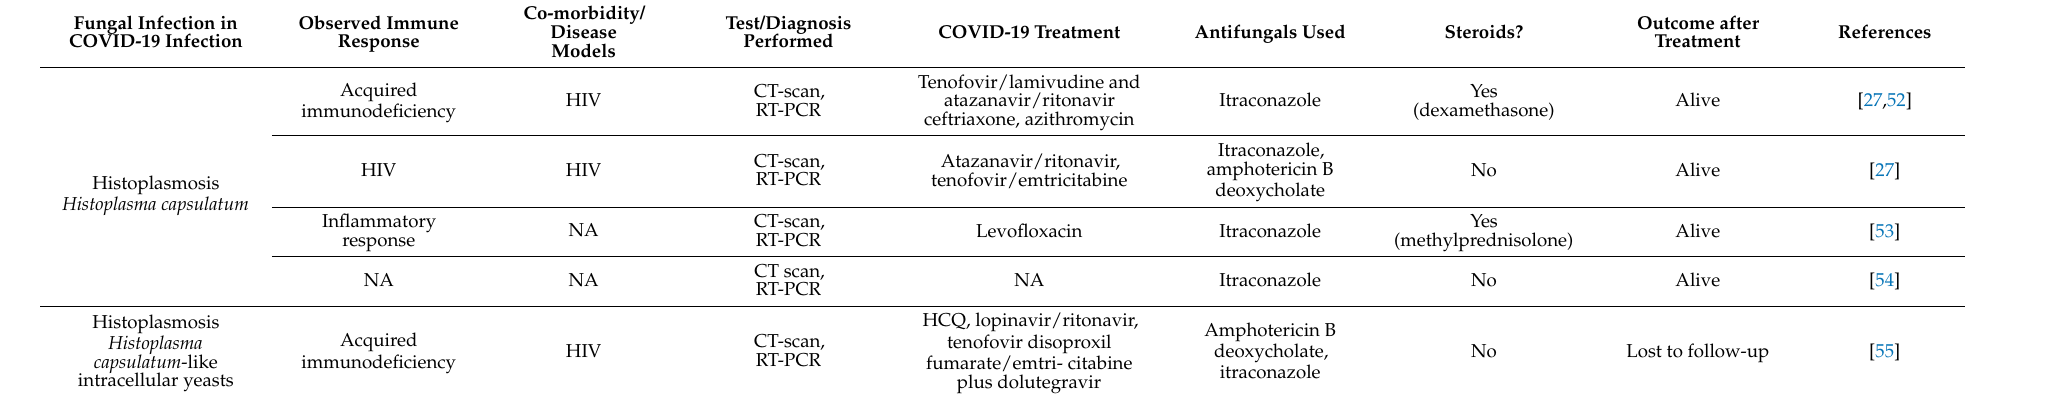
Table 3. Clinical characteristics of COVID-19 patients reported with histoplasmosis.